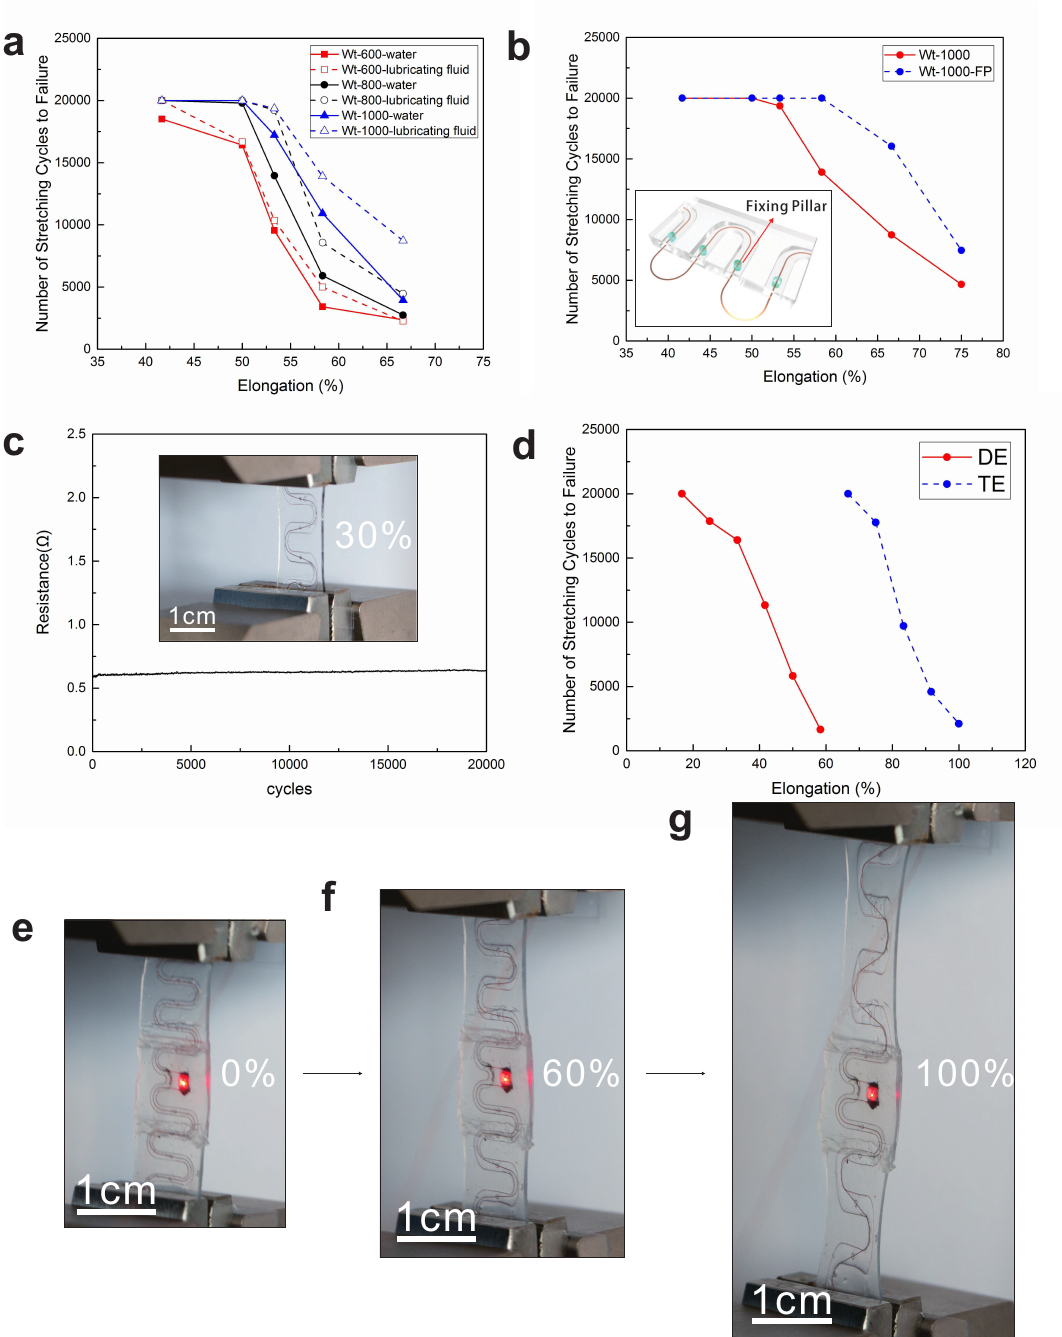
Figure 4. ( a ) Experimental results for effect of lubricating fluid on lifetime of samples with different tunnel widths (sample thickness Ts = 500 µ m and height of the tunnel Ht = 100 µ m). ( b ) The corresponding improvement in lifetime when adopt fixing-pillars (300 µ m in diameter) in the tunnel filled with lubrication fluid (Ht = 100 µ m, Wt = 1000 µ m, Ws = 1 cm, Ts = 500 µ m) and schematic illustration of fixing-pillars (insets). ( c ) Experimental results of resistance change with fixing-pillars in tunnel (Ht = 100 µ m, Wt = 1000 µ m, Ws = 1 cm, Ts = 500 µ m) and optical images of deformation with pillars in tunnel at 30% strain. ( d ) Experimental results of serpentine with direct encapsulation and tunnel encapsulation in Ecoflex. ( e – g ) Optical images of device before stretched and morphology at 60% and 100% applied strain,